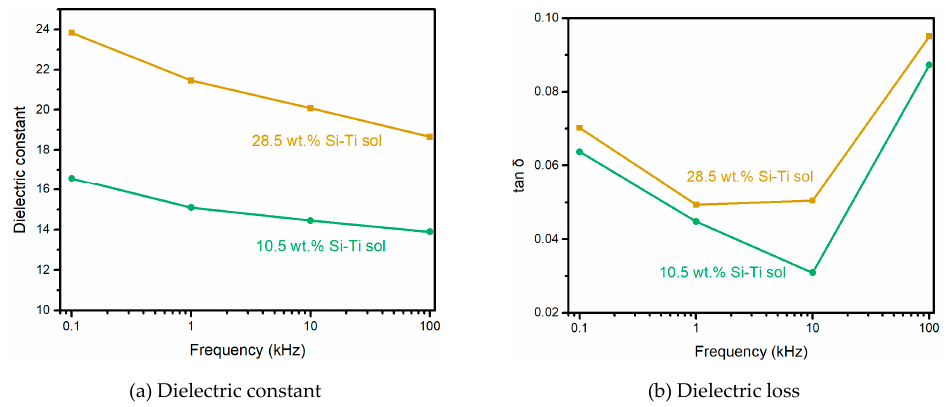
Figure 8. The dielectric constant ( a ) and dielectric loss ( b ) of ePTFE film coated by an MSQ aerogel layer with 10.5 wt.% and 28.5 wt.% Si-Ti sols.